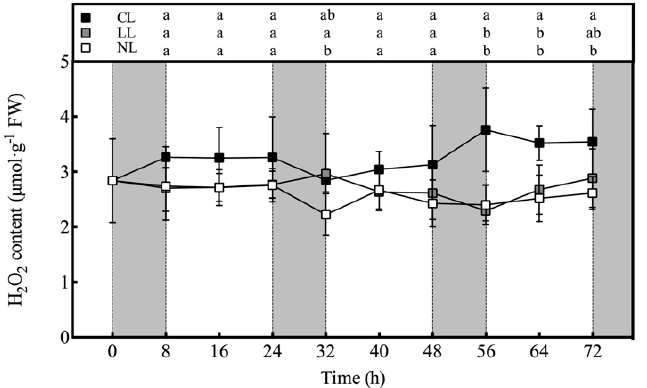
Figure 4. Effects of light intensities at night time on the H 2 O 2 content in lettuce leaves under red